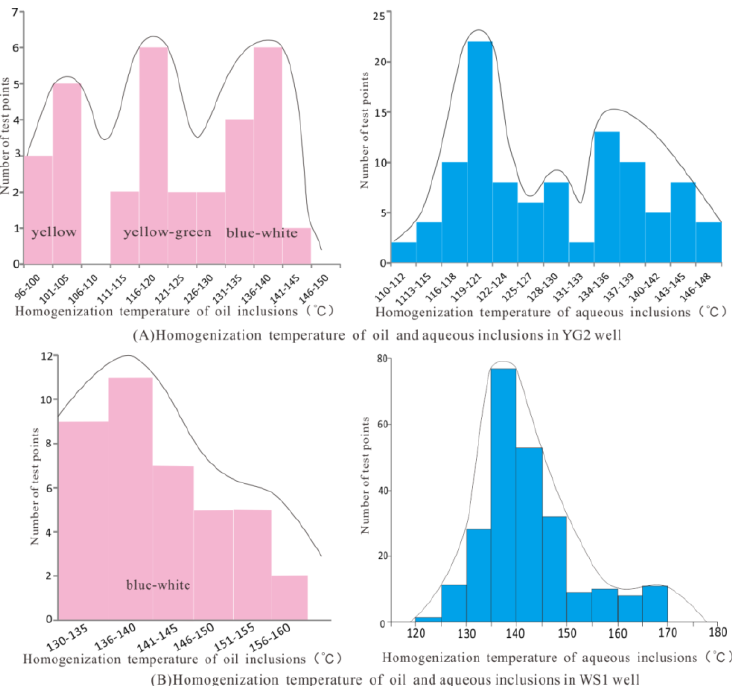
Figure 6. Homogenization temperature of inclusions in the Permian reservoirs. ( A ) represents the homogenization temperature of inclusions in the WS1 well, and ( B ) represents that in the YG2 well.